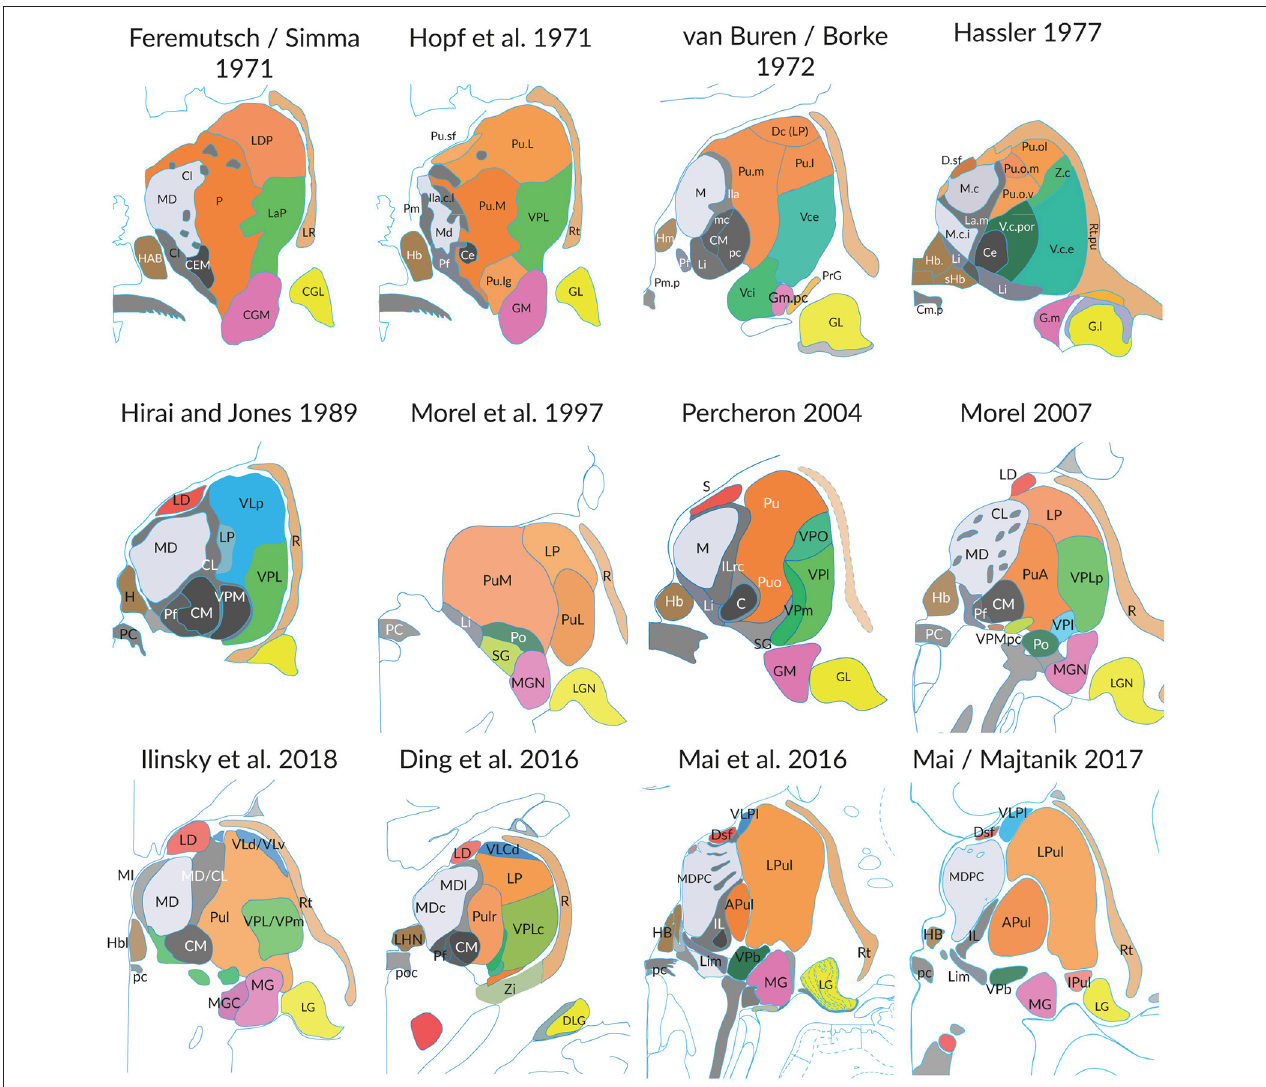
FIGURE 1 | Individual differences of the thalamus in post-mortem brains (medial is to the left). Each figure shows the cross-section areas and topographies of individual thalamic nuclei in coronal sections at the level of the posterior commissure as presented in the original work of the authors. The section planes are close to perpendicular to the intercommisural line (ICL), the reference line connecting the anterior and posterior commissure, except the slices from Hopf, Feremutsch and Simma, Hirai and Jones, Ding. These are tilted up to 22 ◦ to the intercommissural plane. The diagrams were redrawn and color was added. The color in each section designates comparable nuclei or territories (blue: cerebellar territory; green: somatosensory complex; orange: pulvinar; light gray: mediodorsal nucleus; dark gray and black: intralaminar nuclei). For abbreviations see Supplementary Table 5 .